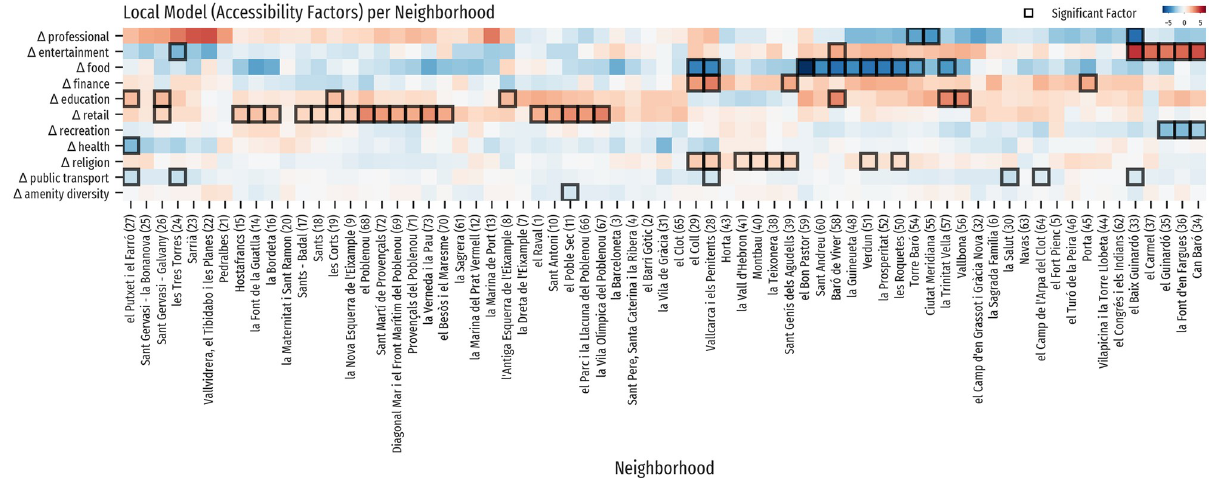
Fig 6. Heatmap of GWR coefficients by neighborhood and variable. This heatmap shows the results from the GWR model, allowing for the identification of clusters of neighborhoods and variables. The colormap is diverging, negative values are blue, positive values are red, and values close to 0 are white. Variables were sorted by their standard deviation and neighborhoods were ordered and clustered using ward linkage distance. The cells with an overlaid black square are statistically significant at the 0.05 level.